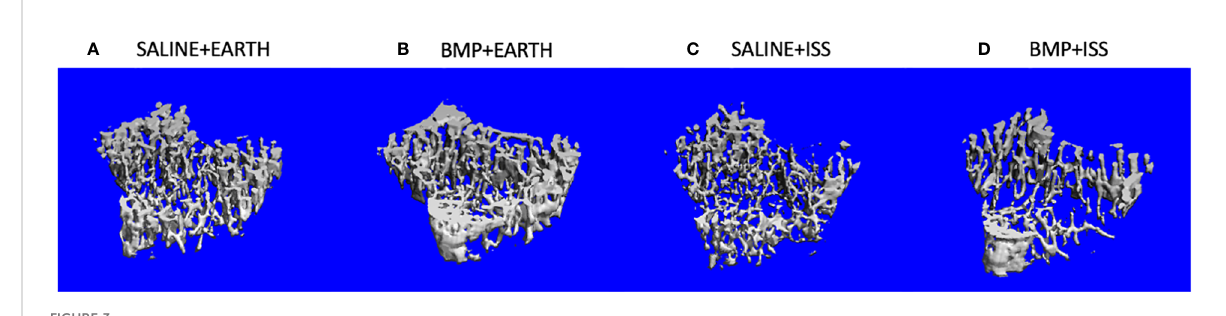
FIGURE 3 Representative 3D µCT reconstructions of the trabecular compartment of tibiae in the following groups: (A) Saline+Earth; (B) BMP+Earth; (C) Saline+ISS; and (D) BMP+ISS. BMP, Bone Morphogenetic Protein 2; ISS, International Space Station; uCT, micro-computed